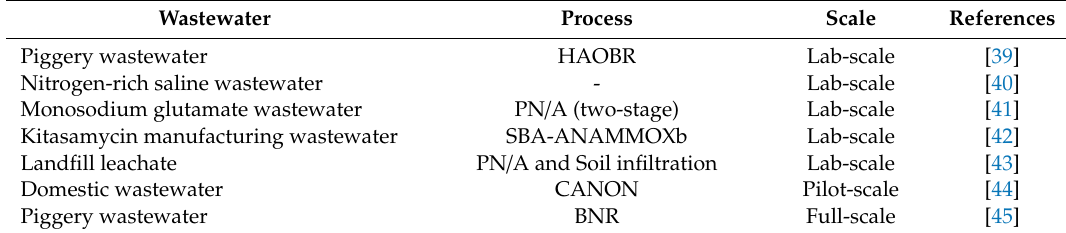
Table 4. Application of anammox in technology to di ff erent types of